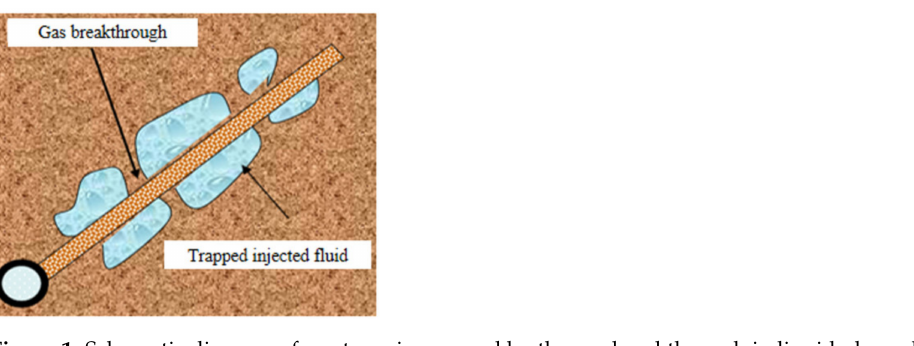
Figure 1. Schematic diagram of gas trapping caused by the gas breakthrough in liquid phase during gas production